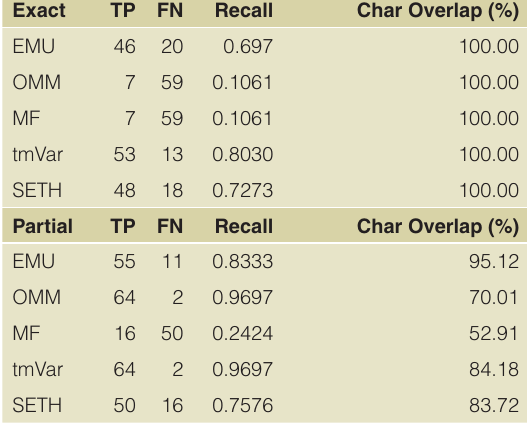
Table 5. Protein extraction recall result on the Variome corpus. Results for exact and partial matching are present. Each row shows the performance of each method in terms of true positives (TP), false negatives (FN) and Recall. The tools are Extractor of Mutations (EMU), OpenMutationMiner (OMM), MutationFinder (MF), tmVar and SNP Extraction Tool for Human Variations (SETH).